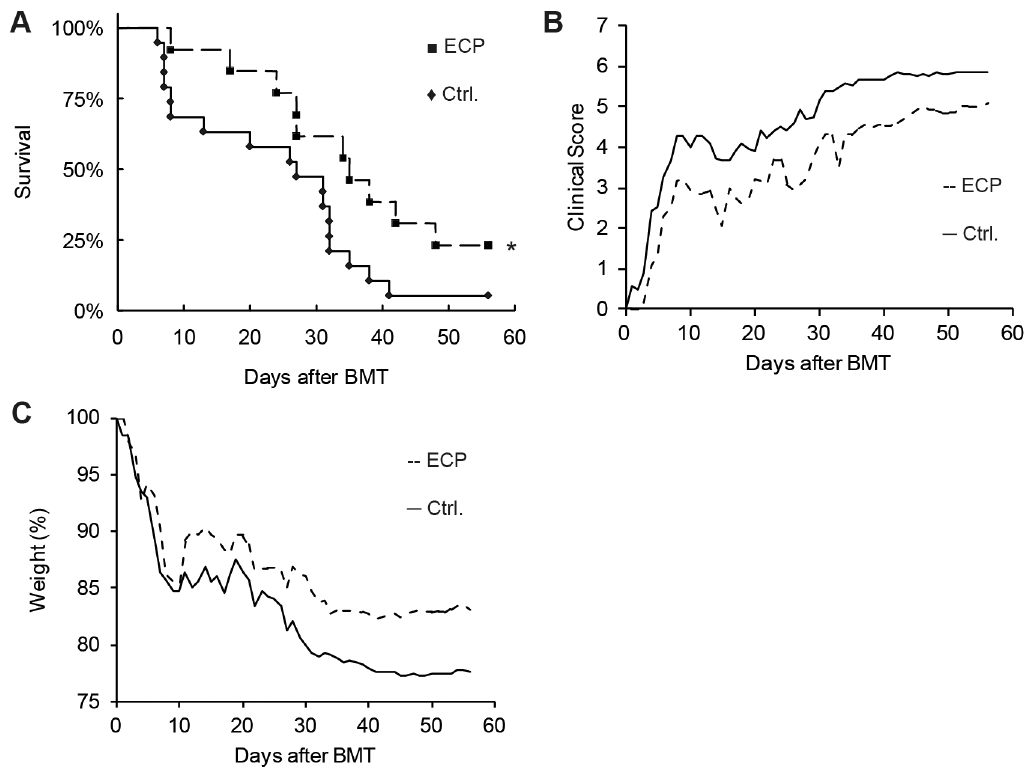
Figure 3. Conventional ECP therapy in the mouse model of acute GvHD. The therapeutic impact of conventional extracorporeal photopheresis (ECP) on GvHD severity in the C57BL/6 R BALB/c mouse model was assessed. Animals of the ECP group ( --- & ) were injected with 8- Methoxypsoralen and UV-A treated splenocytes from another cohort of C57BL/6 R BALB/c transplanted GvHD animals with identical genetic chimerism. Animals received 3 ECP treatments in weekly intervals, started at day 1 after BMT. Control animals ( — ¤ ) received PBS injections at the same time points. Kaplan-Meier plot showing survival rates of the ECP treated vs. PBS control group (A). The ECP group consisted of 13 and the control group of 19 animals (*p , 0.05, log rank test). Clinical GvHD score (B) and weight loss (C) were assessed daily.